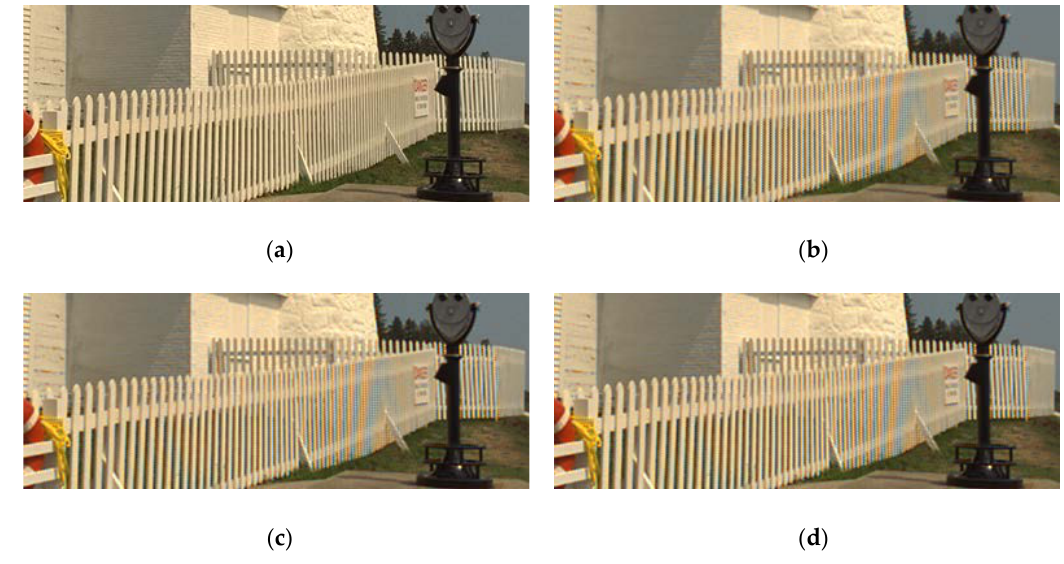
Figure 9. A partial enlargement of Figure 7s: ( a ) original image, ( b ) bilinear interpolation, ( c ) APIDCT interpolation, and ( d ) APDST interpolation.